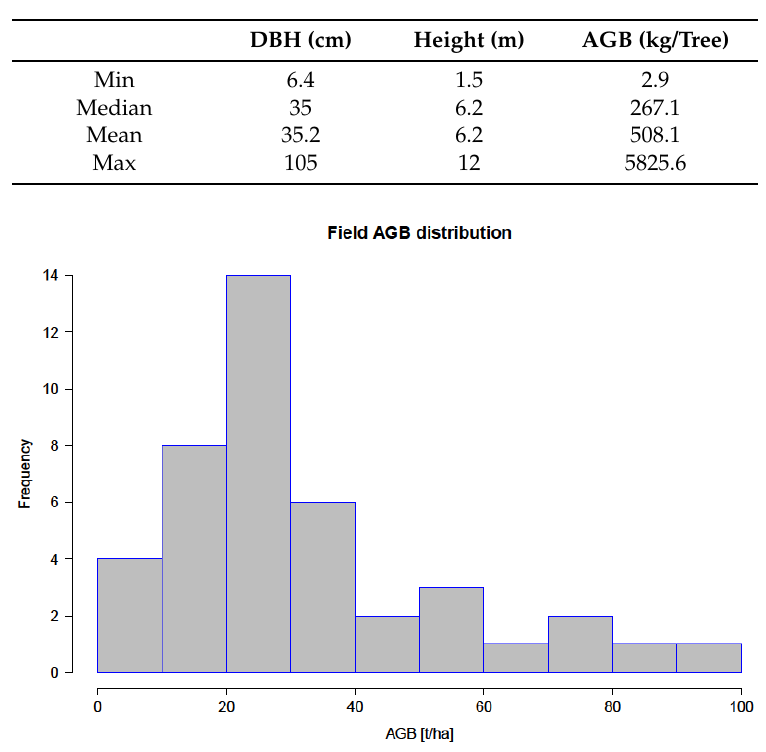
Figure 4. Aboveground woody biomass distribution from field inventory